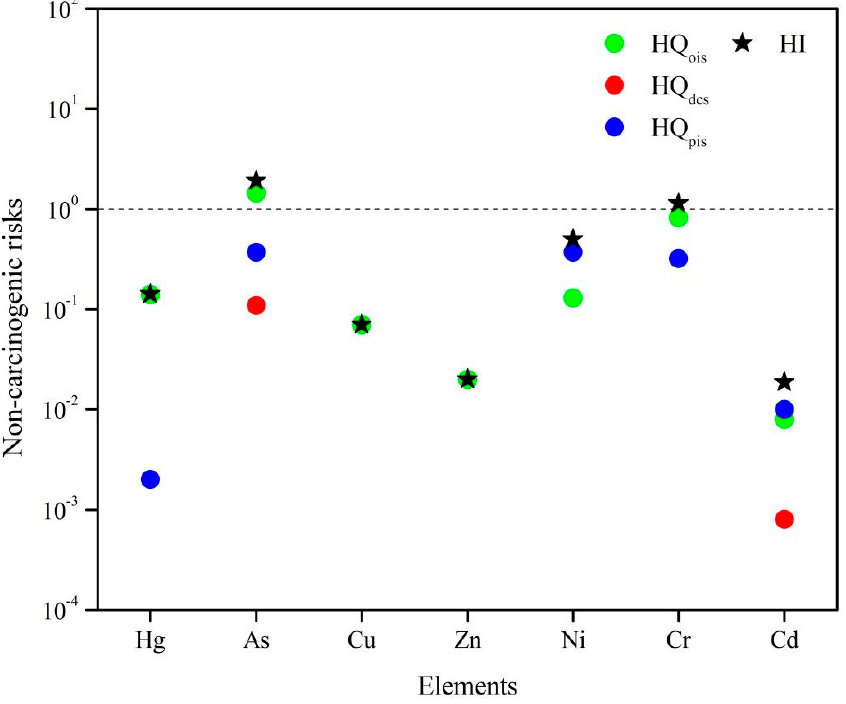
Figure 6. Non-carcinogenic risks of heavy metals in topsoils around industrial sites in Dongguan.